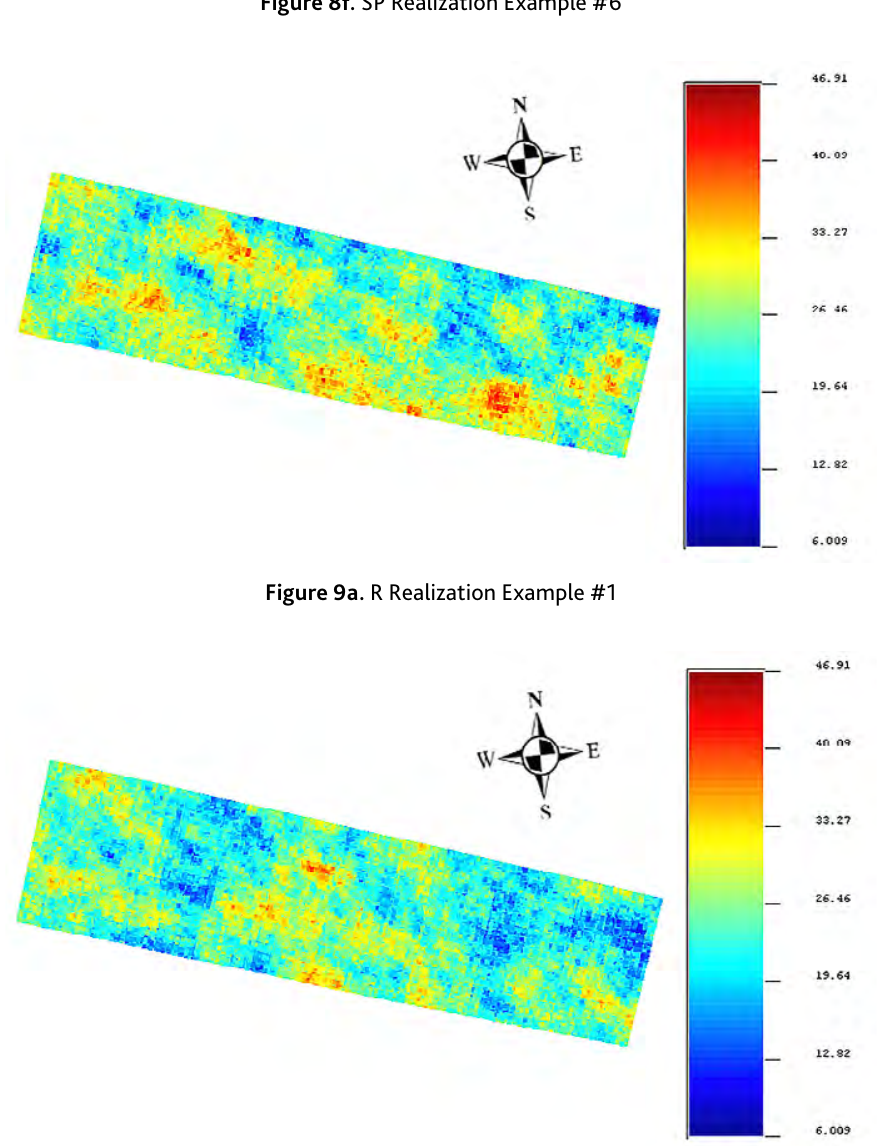
Figure 9b. R Realization Example #2